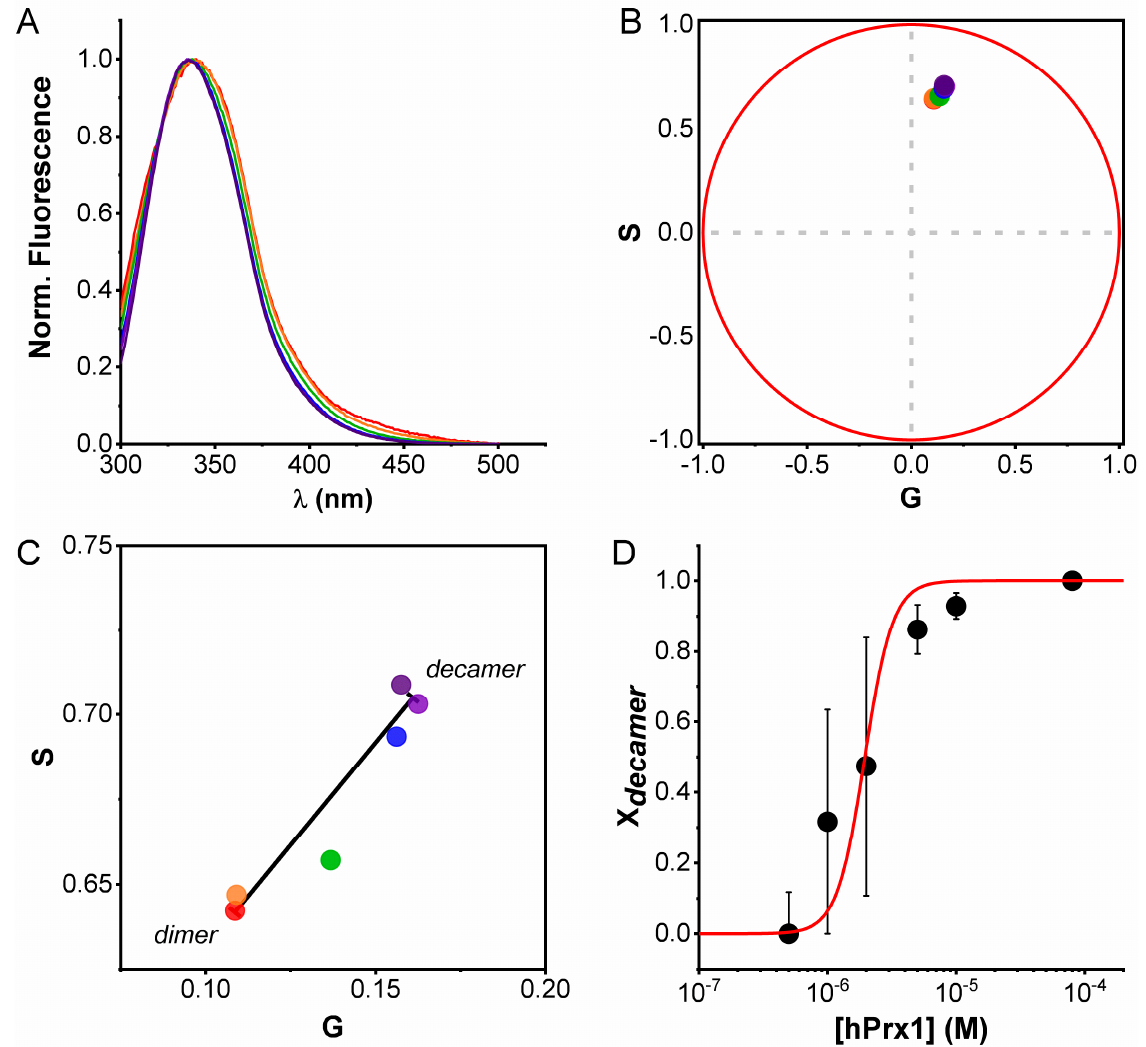
Figure 4. Dissociation of hPrx1 followed by spectral phasors . ( A ) Normalized emission spectra of hPrx1 ( λ exc 280 nm) at different concentrations (from red to dark violet: 0.5, 1, 2, 5, 10, and 80 μ M). ( B ) Spectral phasor plot of the emission spectra in ( A ). ( C ) Phasor points for each emission spectrum are shown (zoom-in of ( B )). The decamer–dimer transition is represented by the black line. ( D ) Plot of X decamer vs. hPrx1 concentration and fitting to the dissociation model. Data are represented as the average ± standard deviation from three independent experiments.